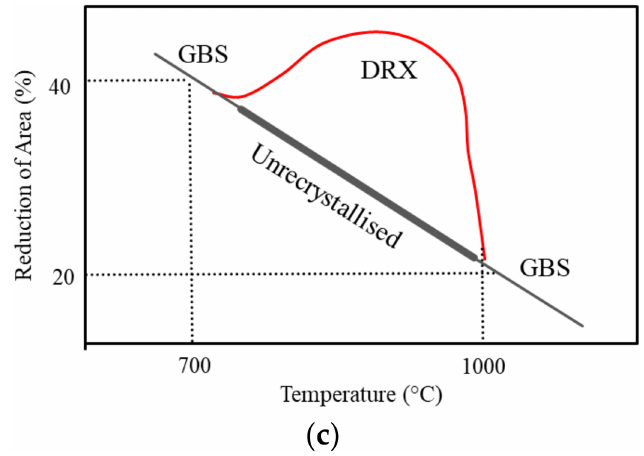
Figure 31. Schematic types of hot ductility curves for high Mn TWIP steels ( a ) No DRX, no fine matrix precipitation, the curve is relevant to straightening ( b ) GBS at the low and high temperature ends of the straightening temperature range but DRX in intermediate temperature range, curve relevant to hot forming ( c ) Separation of curve in ( b ) into regions of GBS and DRX and drawing a straight line relationship for continued GBS in the temperature range in which DRX is occurring